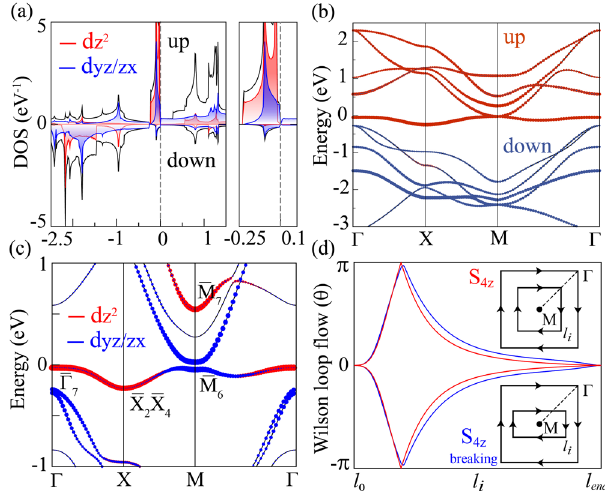
Fig. 2 The electronic structures of cb-AFM monolayer FeSe. a Projected DOS of the 3 d -orbitals on Fe 2 for the calculations without SOC. b Spin-polarized band structures with the red (blue) color indicating the minority (majority) spin states. c Band structures with SOC, the red and blue color indicate the weights of d z 2 -orbital and d yz / zx -orbital, respectively. d The Wilson loop spectra of the isolated nearly fl at band. The red (blue) lines represent the square (rectangle) Wilson loop spectra with loops patch in the upper (lower) right inset panel, where the arrow indicate the direction of